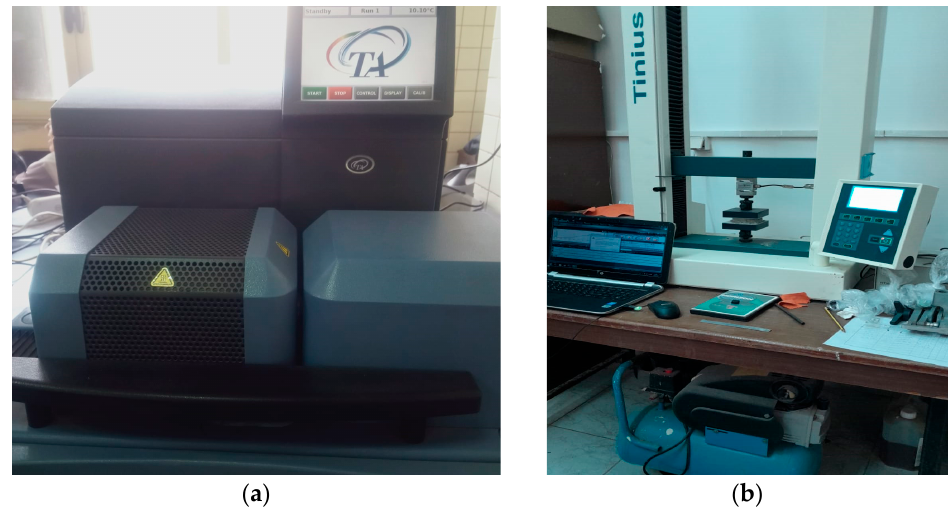
Figure 2. ( a ) Thermal analysis, ( b ) generic compression devices used in this work.